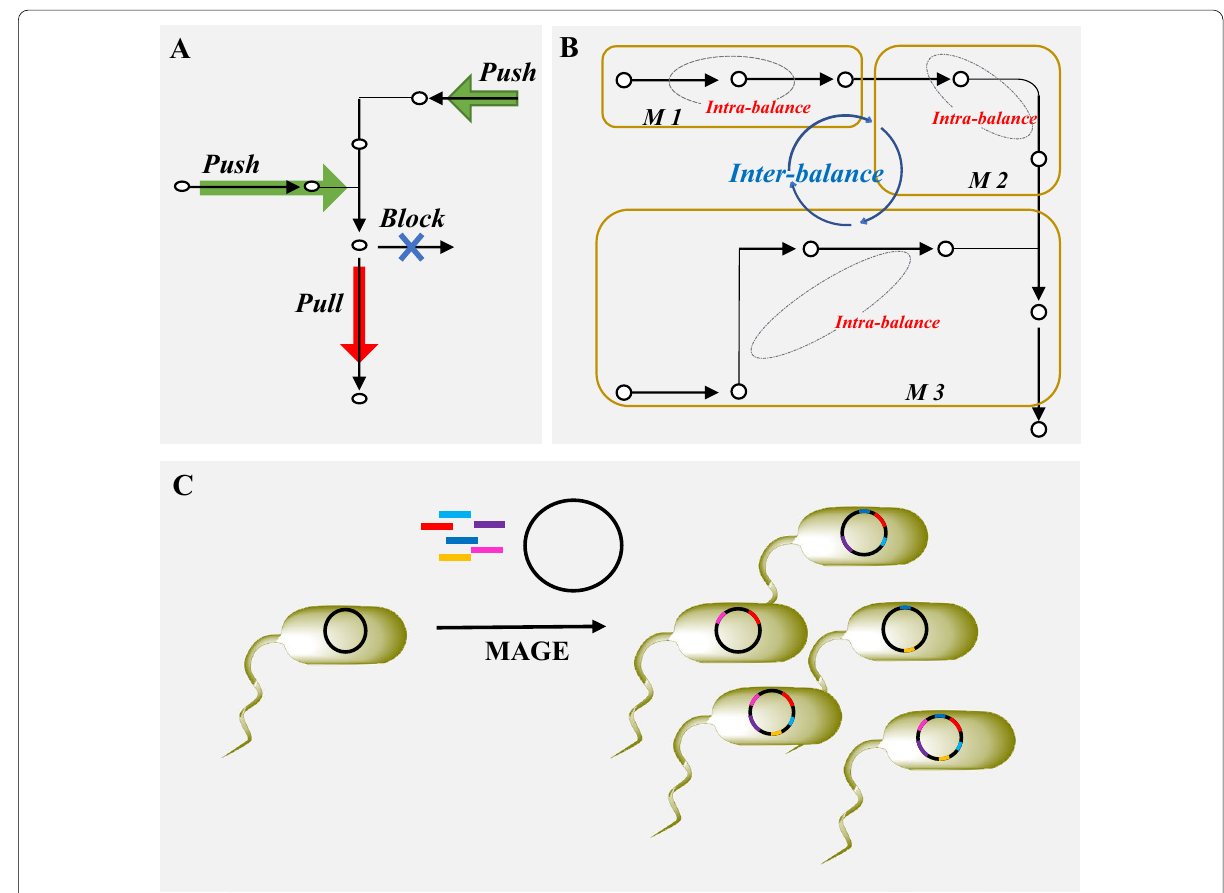
Fig. 5 Overview of strategies for engineering of metabolic network in heterologous biosynthesis. A “Push–pull–block” strategy is used to direct more metabolic flux to the target compounds, in which “push” indicates enhancing the precursor supply towards target products, “pull” means strengthening the formation ability of the target products, and “block” represents downregulation of the competing pathways. B Inter- and intra-modular pathway engineering strategy is proposed to regulate metabolic balance among multiple modules as well as individual genes within each module. C Multiplex genome engineering like multiplex automated genome engineering (MAGE) is applied for large-scale programming of cell factory. In MAGE, synthetic ssDNA pools (color lines) are transformed into engineered hosts for generation of a diverse set of genomic